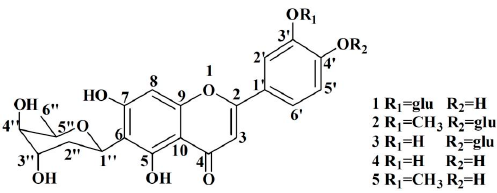
Figure 1. The structures of compounds 1 – 5 .